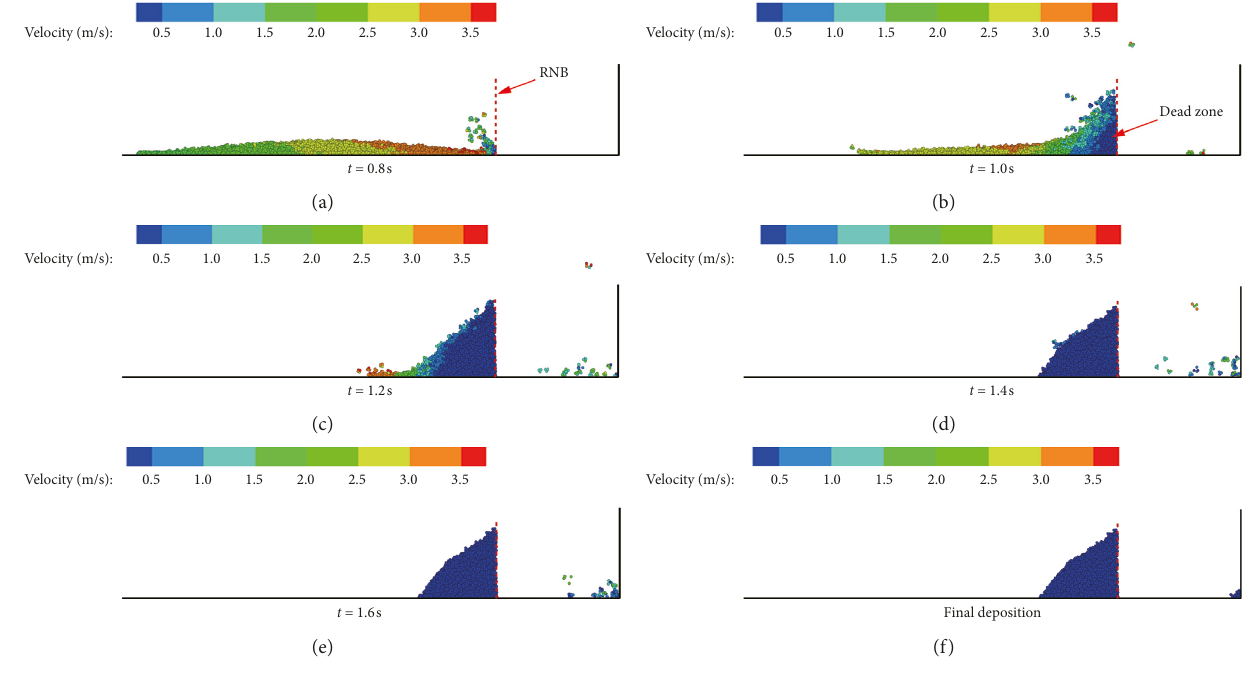
Figure 10: Granular flow process in Case A1.